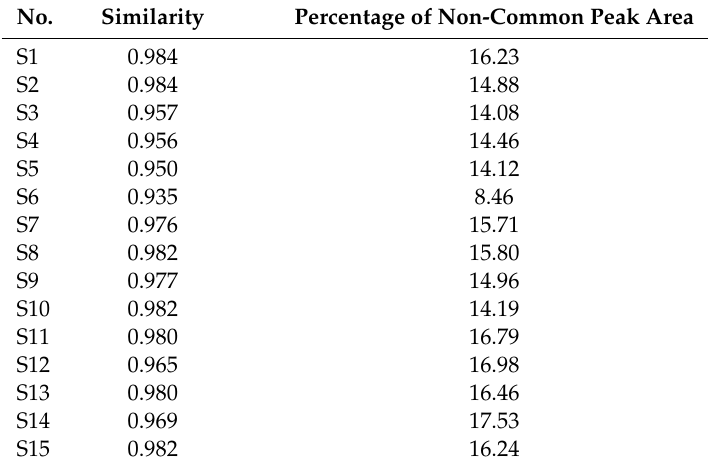
Figure 3. The UPLC fingerprint of fifteen batches of samples S1–S15. A common pattern was extracted and used as reference fingerprint (R). Among these 49 common peaks: c1—chlorogenic acid (peak 12); c2—liquiritin (peak 22); c3—rutin (peak 27); c4—forsythoside A (peak 33); c5—isochlorogenic acid A Table 3. The Similarity of fifteen batches of samples.